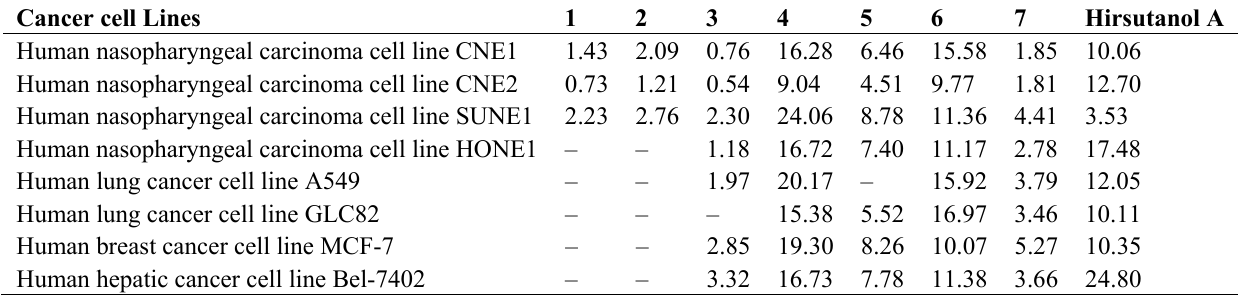
values in µM a . 50